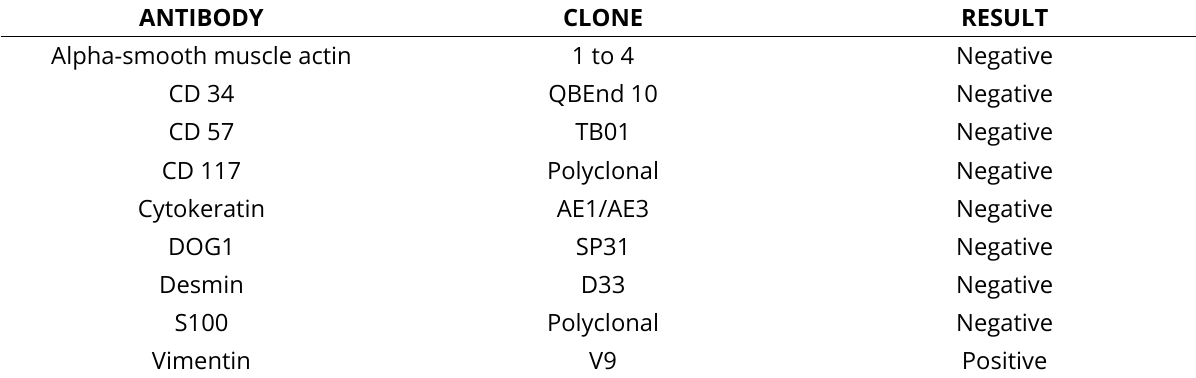
Table 1. Immunohistochemical profile of the lesion resected at gastrectomy.